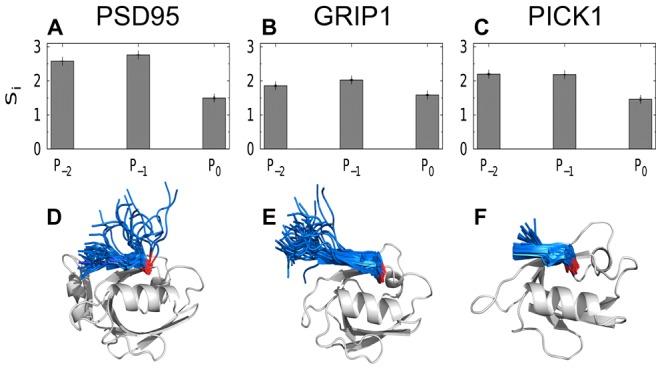
Interplay between peptide binding specificity and structural heterogeneity.A useful feature of the peptide screening method is that the underlying joint probability distribution  (see Figure 1) can provide further insight into the structural underpinnings of specificity. Shown is a simple analysis of the specificity profiles of PSD95, GRIP1, and PICK1 in Figure 4. (A–C) The degree of sequence randomness at different peptide positions i, as measured by the sequence entropy , where  is defined as in Figure 4 and the sum goes over all 20 different amino acid types . For reference, we note that for a position in which all amino acid types occur with equal probability, . (D–F) Superposition of a random sample of bound state conformations  with various peptide sequences , in ribbon representation (peptides shown in blue and PDZ domains in grey). For clarity, only single structures of the PDZ domains are shown. We find that the relatively larger structural heterogeneity at  for peptides bound to PSD95 is connected to a higher . The C-terminal amino acid, , (red) is tightly bound to the peptide-binding pocket in all 3 cases and this feature is conserved across different binding-competent sequences.